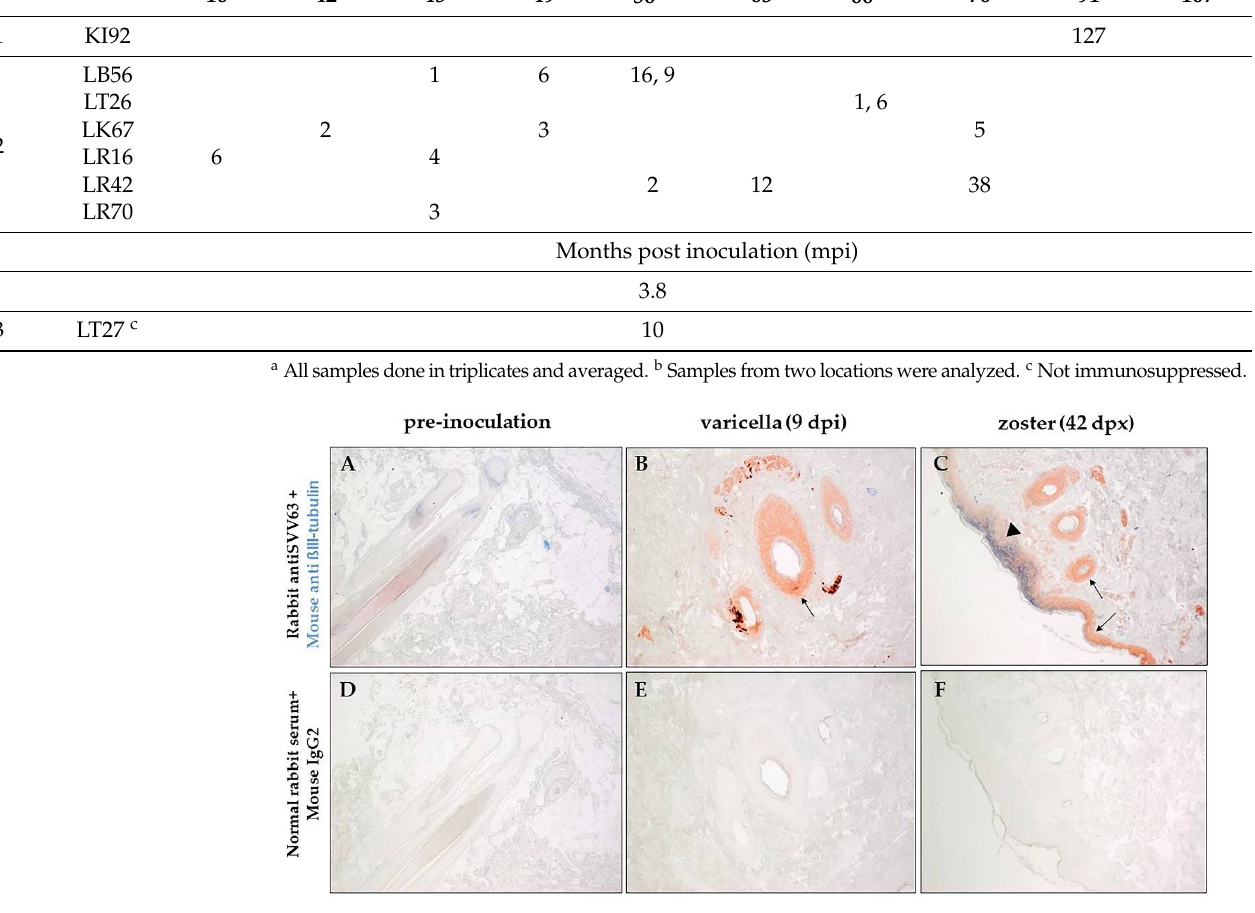
Figure 3. Immunohistochemical analysis of varicella and zoster skin rash from the same rhesus macaque. Sections of biopsied, zinc formalin-fixed, paraffin-embedded skin samples before inoculation with SVV (pre-inoculation), 9 dpi (days post-inoculation) and 42 dpx (days post-immunosuppression) from rhesus macaque LK67 (group 2) was analyzed using dual-color staining. Rabbit polyclonal antibodies against SVV IE63 protein (red) and mouse monoclonal antibody directed against human β -III tubulin (blue) were used as described in methods to identify the presence of virus antigen and its proximity to nerve endings. Normal rabbit serum and mouse anti IgG2a were used as negative controls ( D – F ). SVV IE63 protein was not detected in the pre-inoculation biopsy ( A ), but was found in hair follicles during varicella and zoster and in the epidermis during zoster ( B , arrows). β -III tubulin was found to colocalize with SVV IE63 protein ( C , arrowhead) in the epidermis during zoster. (Magnification, ×